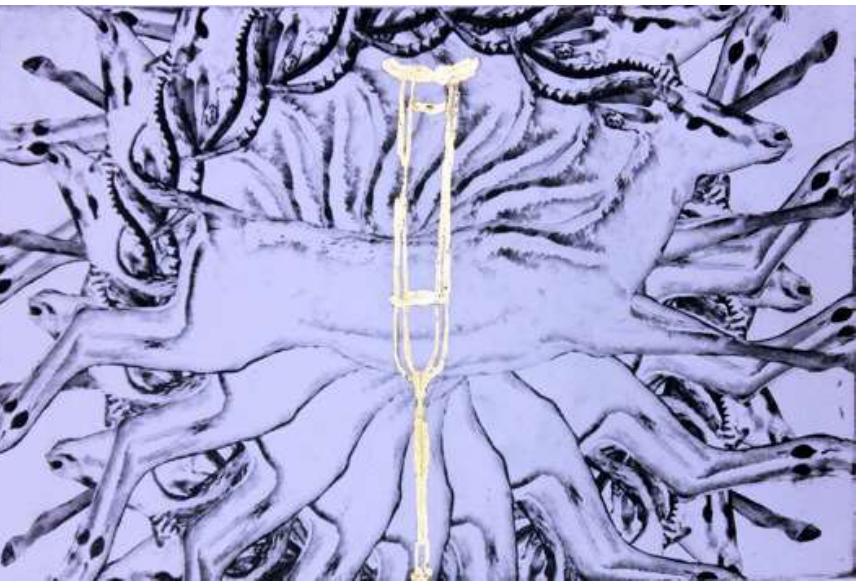
Figure 4. Manal Mahamid, Keep Running, Photo etching & mixed media on archival paper, 38 × 26 cm, 2015, Edition 1 of 4.